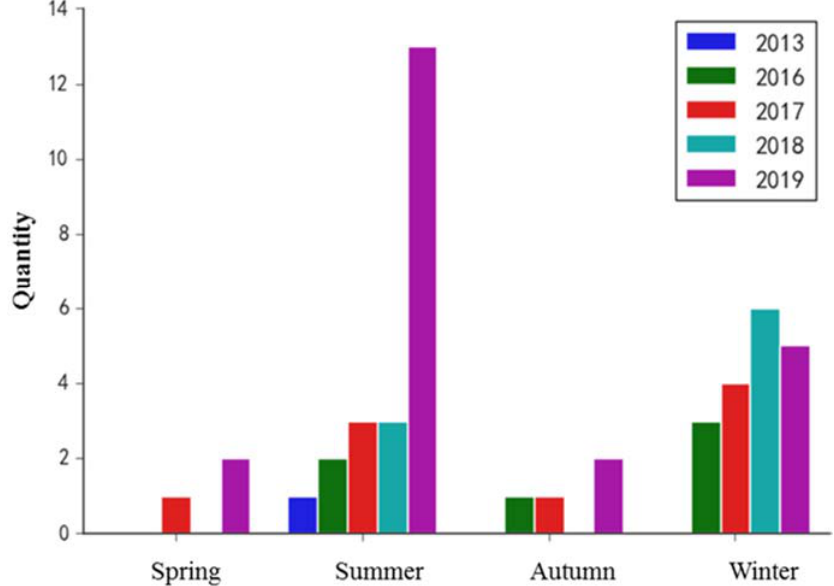
Figure 4. Period of fire occurrence.